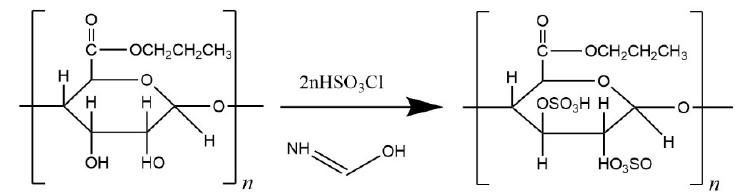
Figure 1. Chemical mechanism diagram.